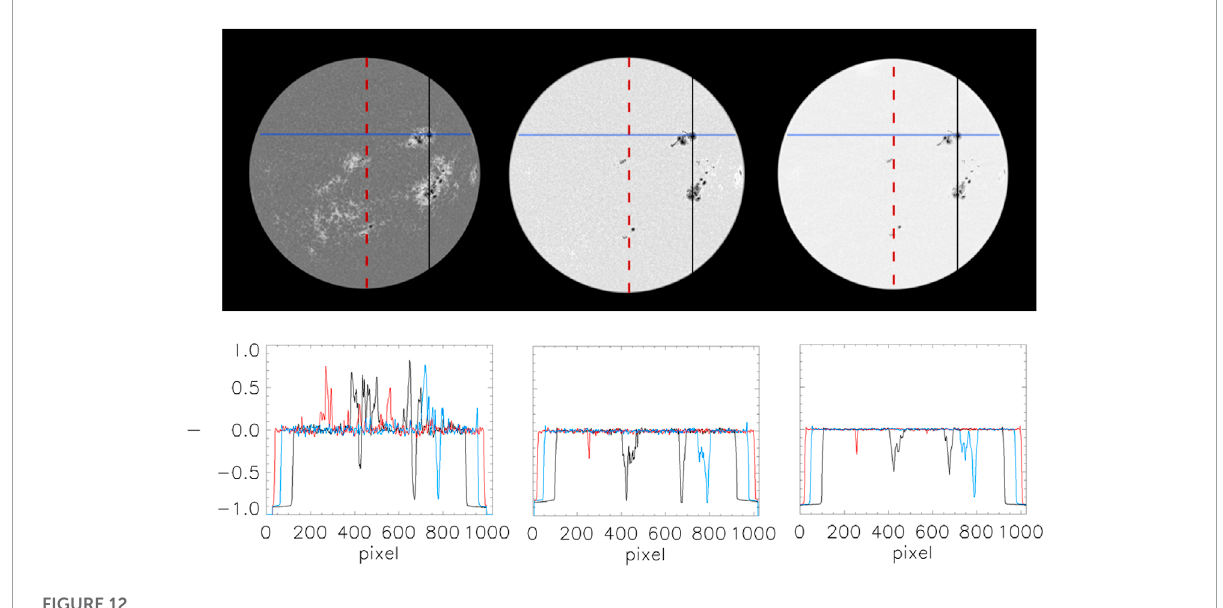
FIGURE 12 Same as Figure 7 but for limb-darkening compensated